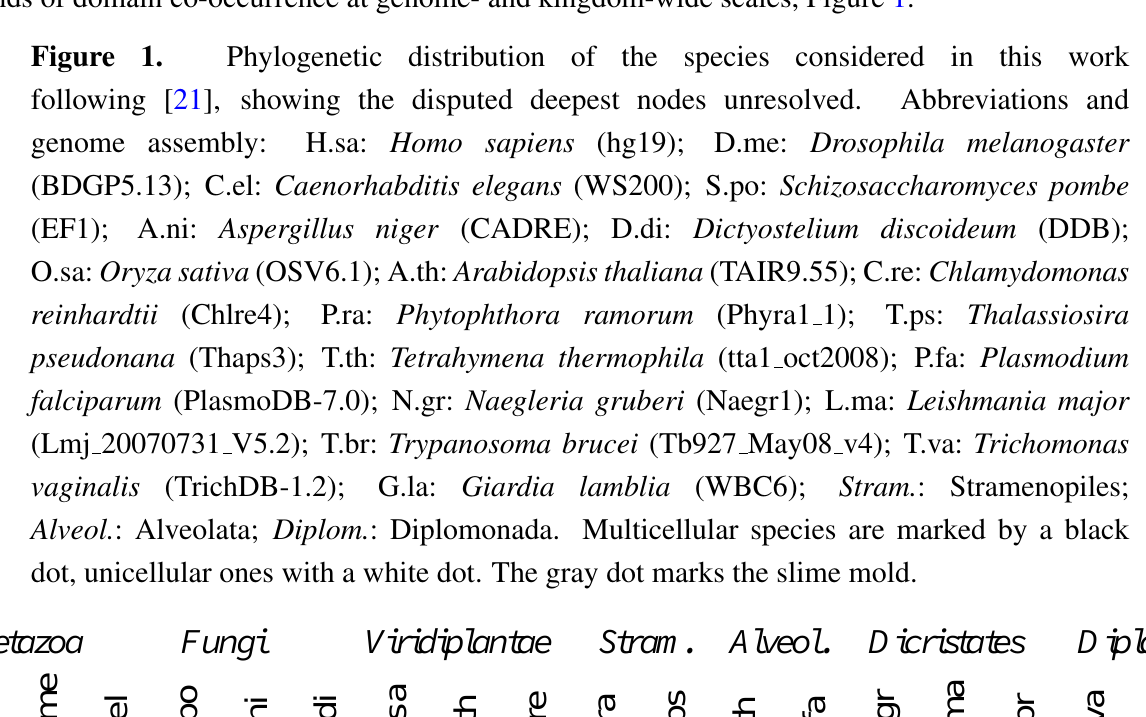
Figure 1. Phylogenetic distribution of the species considered in this work following [21], showing the disputed deepest nodes unresolved. Abbreviations and